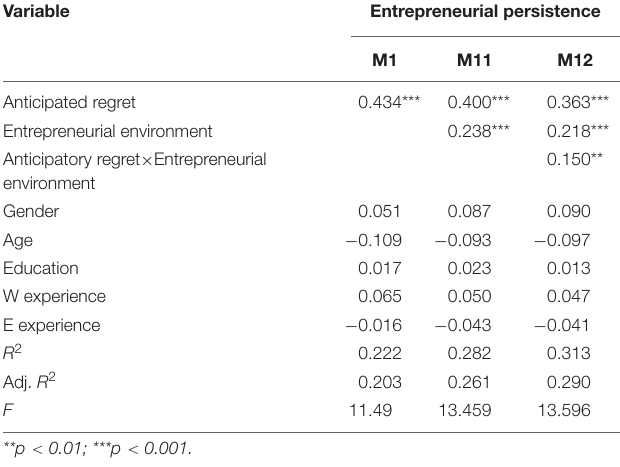
TABLE 5 | Results of the moderating effect test.